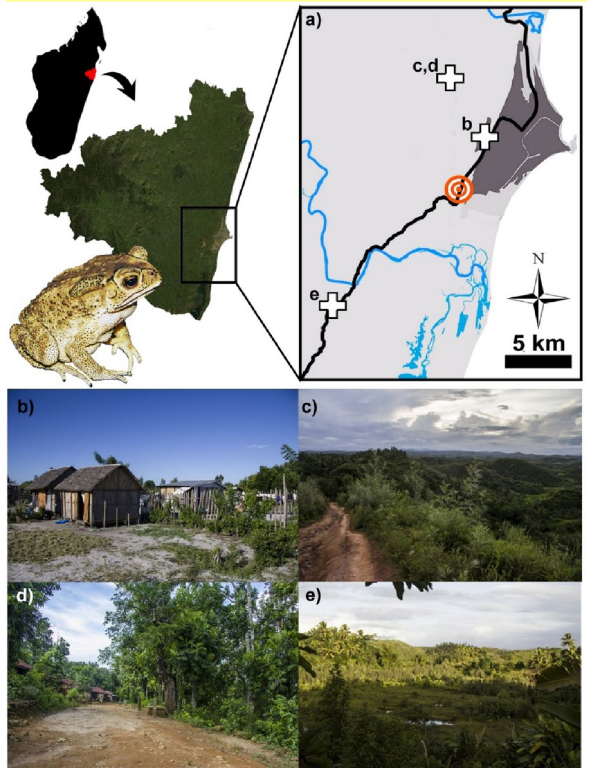
Figure 2. Map of the study area with the sites (white crosses) where the radio-tracking study of the Asian common toad was conducted ( a ) showing the putative point of introduction 31 (red bullseye), and the main road connecting Toamasina to Antananarivo (black line). Representative photographs of the main landscapes of the study sites: ( b ) Ambodisaina; ( c,d ) Vohitrambato route; ( e ) Invasion forefront. We created the map in Fig. 2a by using the software ArcGIS (vers. 10.2; https:// www. arcgis. com/ index.